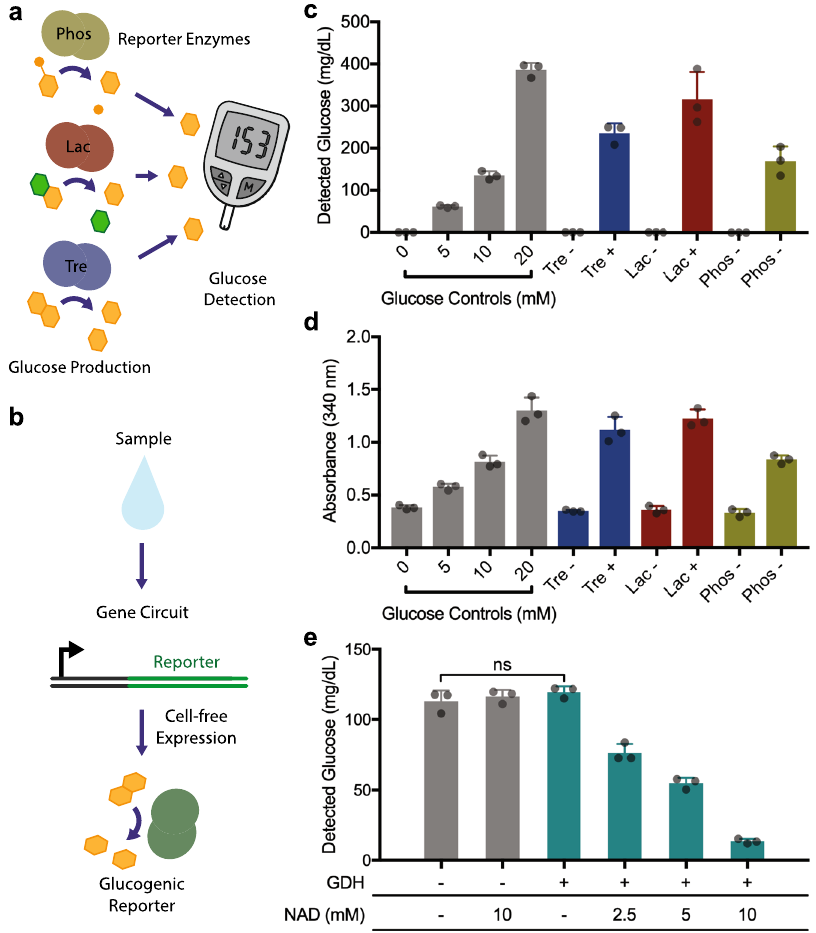
Fig. 1 Development of a glucose meter interface for cell-free, gene circuit-based sensors. a Concept schematic of glucose generation by reporter enzymes upon the activation of gene circuit sensors. b Expression of different reporter enzymes can be used to generate glucose using their respective substrates. c Using a glucose meter for measurement, glucose is generated from the expression of three enzymes: trehalase (Tre), lactase (Lac), phosphatase (Phos). 5 ng/ µ L plasmid DNA used for expression, reactions incubated for 16 h. Control reactions (-) were identical, but lacked DNA encoding an enzyme. d Cell-free protein expression reactions were also analyzed for glucose production using a colorimetric GDH-NAD absorbance-based assay. e Using the expression of GDH and a titration of NAD concentration, glucose can be selectively removed from samples. Negative controls ( − ), without GDH and/or NAD, show no background glucose degradation. GDH DNA added to 10 ng/ µ L. All data presented are the mean of N = 3 independent experiments (as indicated by dot plots) ±SD. Statistical analysis: one-way ANOVA, ns = not signi fi cant. Source data are provided as a Source Data fi